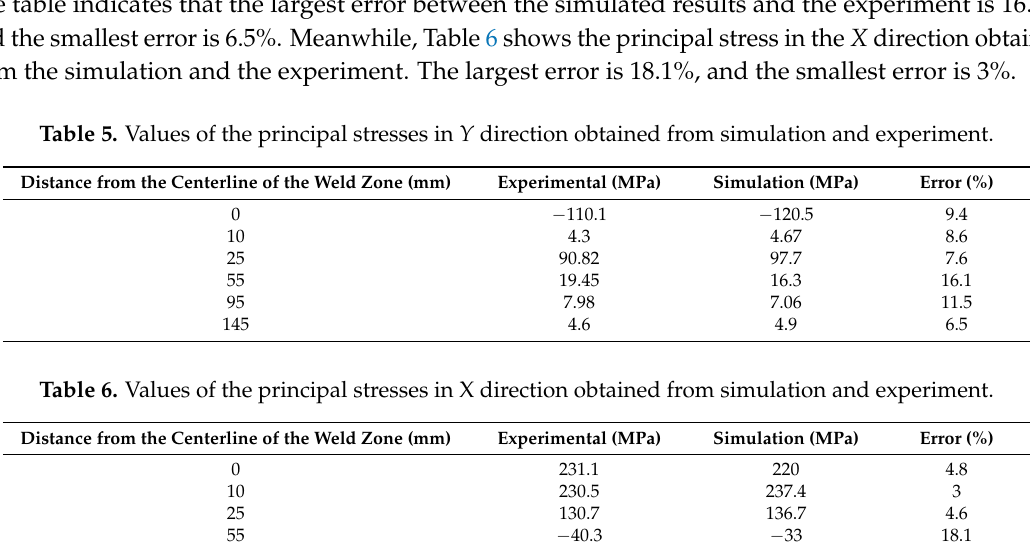
Figure 11. Comparison of the principal stresses between simulation and experiment. ( a ) The stresses in the Y direction (perpendicular to the welding direction); ( b ) the stresses in the X direction (parallel to the welding direction).